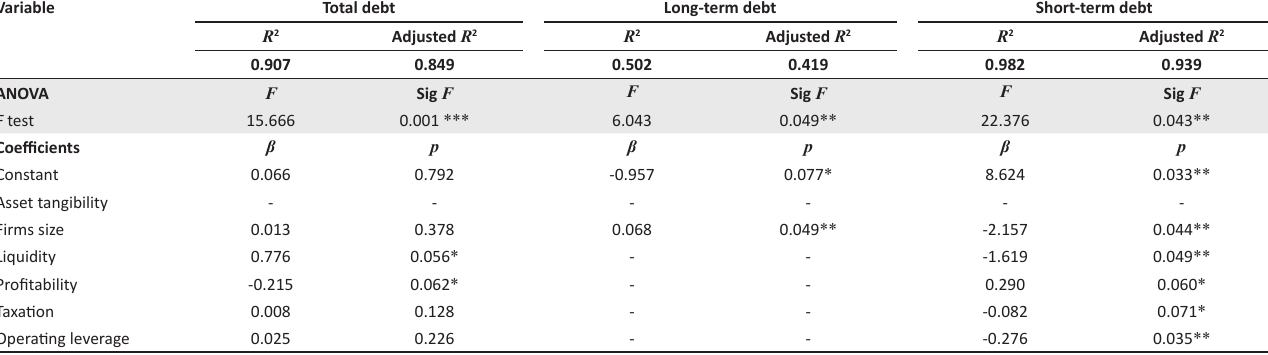
TABLE 6: Multiple regression coefficients: Summary: Total sample